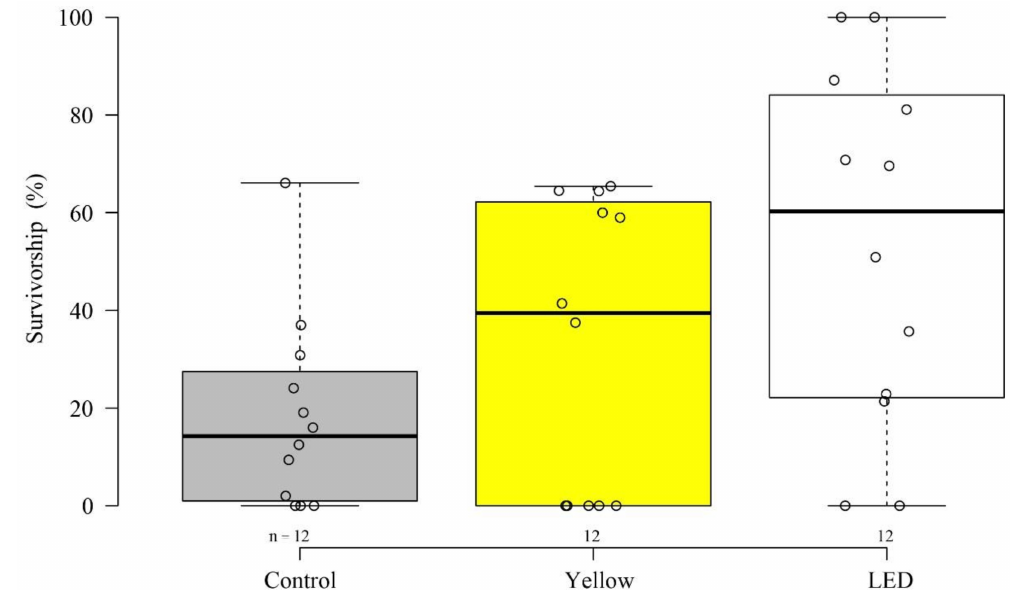
Figure 2. Survivorship (%) after one year (June 2017–June 2018) under ambient conditions—control (gray), ‘LED’ (LED lamp, white), and ‘Yellow’ (fluorescent lamp, yellow) light treatments. The circles represent survivorship on each settlement tile ( n = number of tiles).